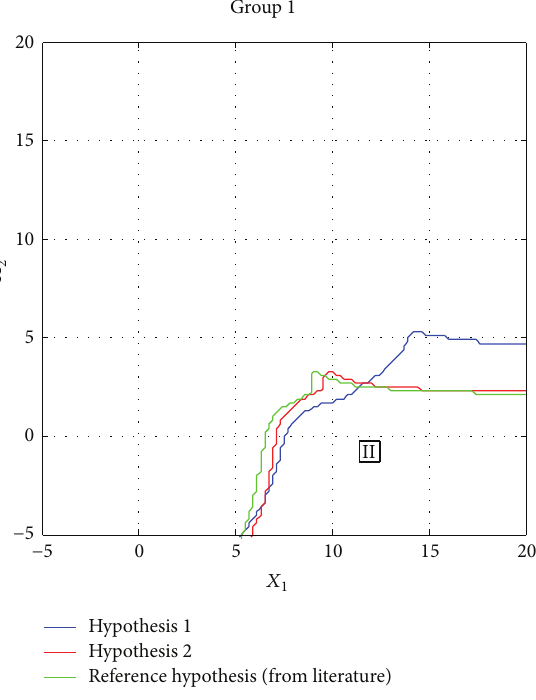
Figure 4: Setup policy (product 1 to product 2).